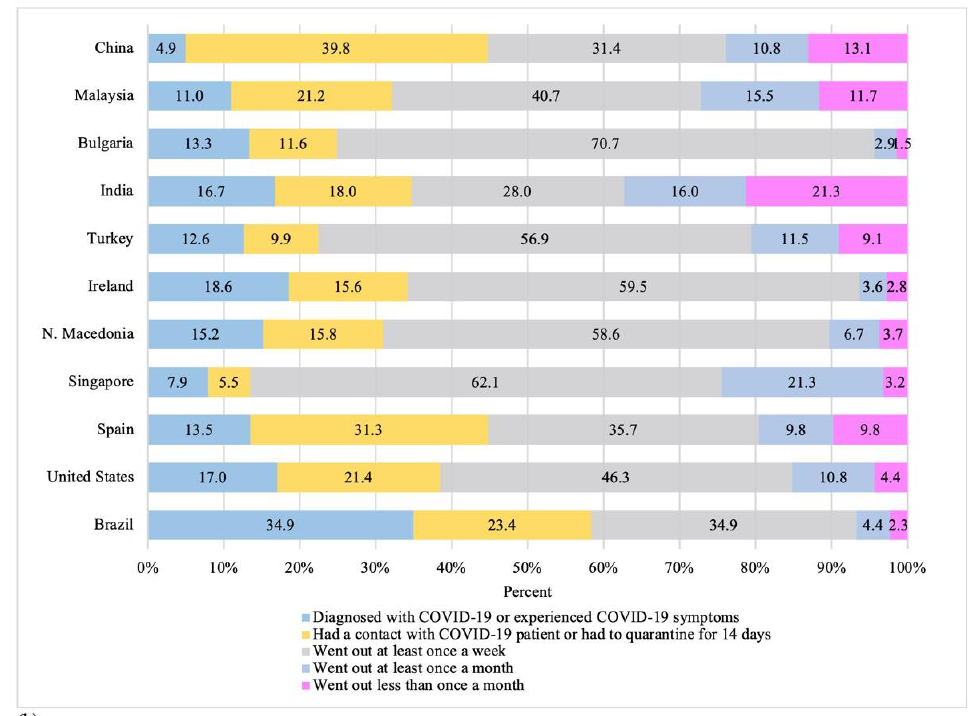
Figure 1. Distribution of country-level COVID-19 factors and personal COVID-19 exposures by participating countries: ( a ) Country-level COVID-19 factors; ( b ) Personal COVID-19 exposures. Note: Country-level COVID-19 factors were measured using two variables: Increase in confirmed cases per million people, capturing each participating country’s average confirmed COVID-19 cases per million people per day during their lockdown; and Governmental policy response to COVID-19, capturing each participating country’s average government stringency index score during their lockdown (0 = no policy response, 100 = strictest policy responses). Government stringency index score was not available for North Macedonia, thus, we used the average scores of its 5 neighboring countries (Albania, Bulgaria, Greece, Kosovo, Serbia) instead. Personal COVID-19 exposure was created based on participants’ COVID-19-related exposures during their country’s lockdown, capturing their highest risk exposure in 1 of 5 mutually exclusive categories (5 = high-risk exposure, 1 = low- risk